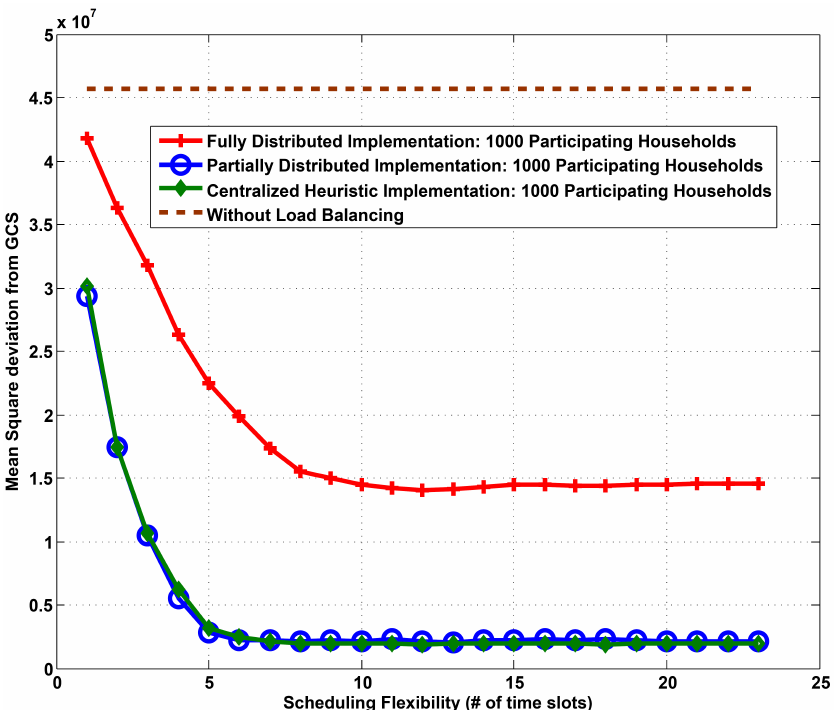
Figure 3. Mean square deviation from GCS vs . scheduling flexibility: 1000 participating